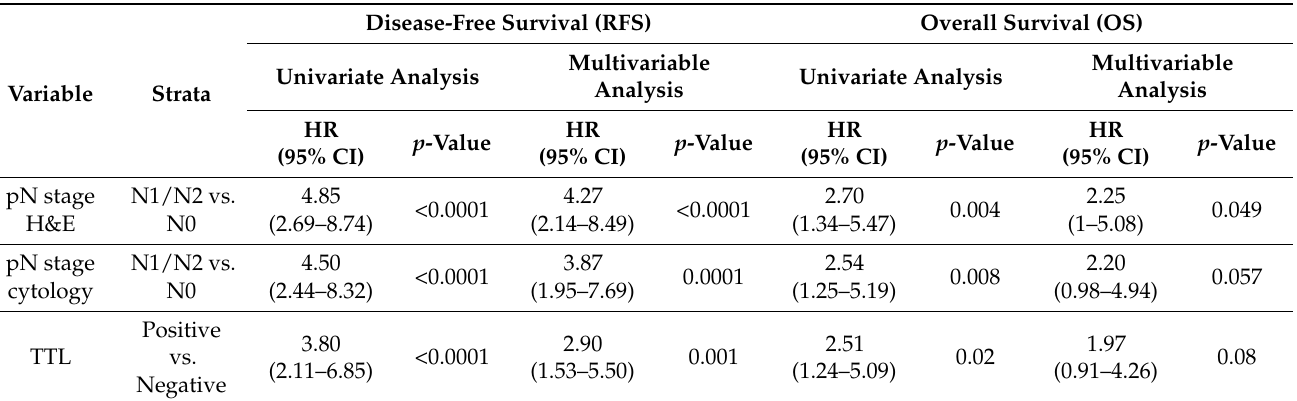
Figure 5. Kaplan-Meier estimates displaying RFS and OS rates according to pN-positive/negative patients by the three methods of LN analysis. p -values were calculated using a log-rank test and hazard ratios (HRs) by Cox proportional hazards models both in univariate and multivariable settings. Multivariable models were adjusted by age, sex, pT stage, and histological grade. H&E, haematoxylin, and eosin; TTL, total tumour load; OSNA, one-step nucleic acid amplification; univ., univariate; multiv., multivariable. Table 4. Patient’s survival related to lymph node status.